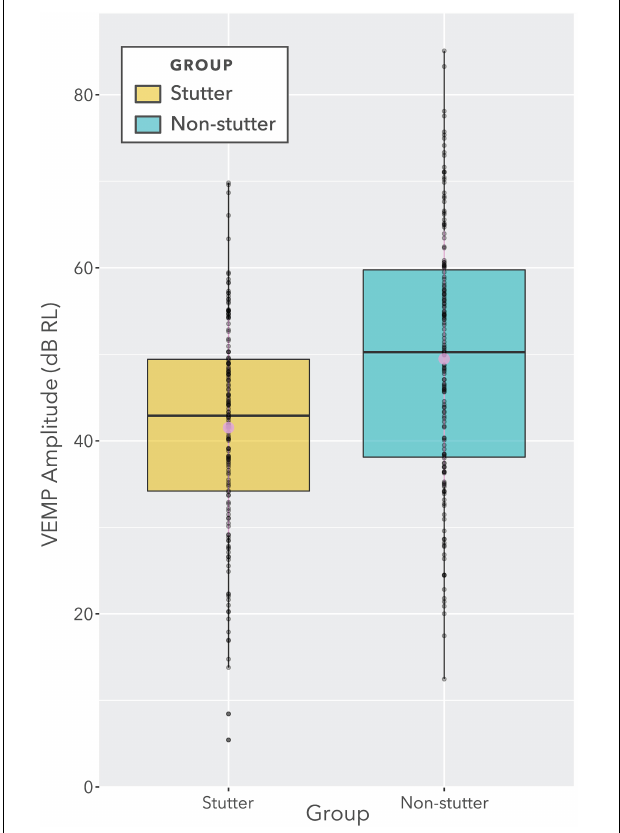
FIGURE 7 | Boxplot showing VEMP p1-n1 amplitudes for stutter and non-stutter groups collapsed across stimulus level (i.e., identical data to Figure 6 ). Log transformation on the ordinate is such that a doubling of the VEMP p1-n1 amplitude in normalised microvolts (i.e., with unity RMS background) corresponds to a 6 dB increase. The two slightly larger circles near the medians denote means. The ratio of difference between medians to overall spread (i.e., to the difference between the lower quartile for the stutter group and the upper quartile for the non-stutter group) is approximately 30%. However, this data presentation is for illustration purposes only. The data contain repeat readings with asymmetries between groups. The actual statistical analysis is via linear mixed-effects regression modelling, and is described in the sections “Statistical Model” and “VEMP p1-n1